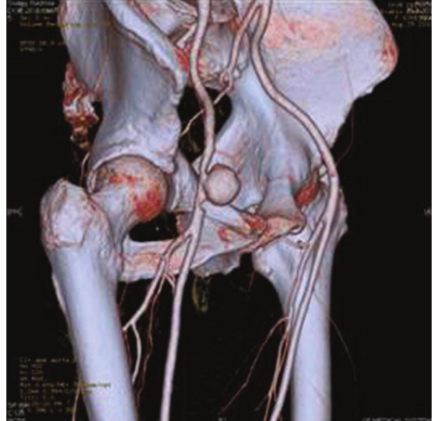
Figure 2: Pseudoaneurysm of right common femoral artery on CT angiography.